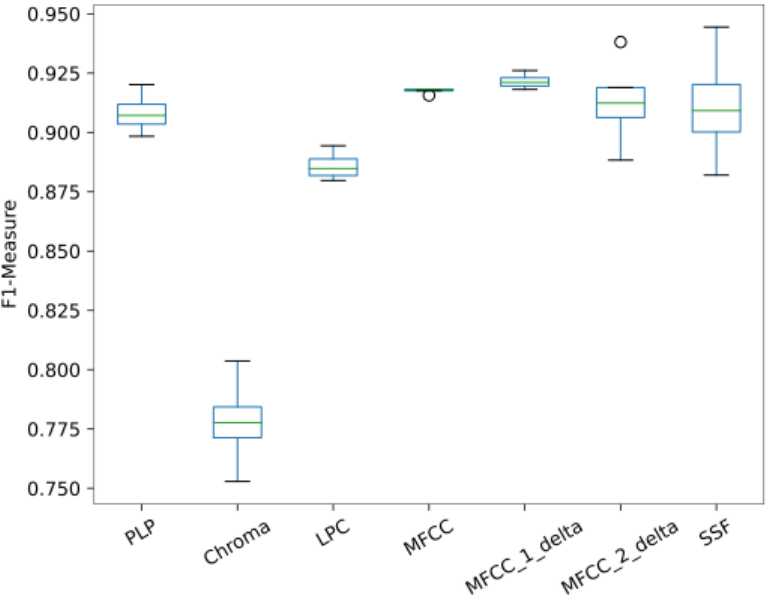
Figure 4. Performance of each audio feature in the Jamendo dataset individually. Circles represent atypical values within the evaluation